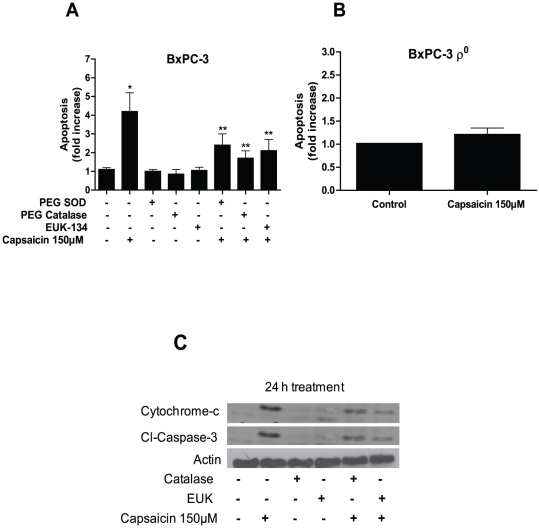
Anti-oxidants prevent capsaicin-induced apoptosis.(A) BxPC-3 cells were pretreated with PEG-SOD (100 U/ml), PEG-catalase (500 U/ml) or EUK-134 (50 µM) for 1 h and then treated with DMSO or 150 µM capsaicin for 24 h, (B) BxPC-3 ρ0 cells were treated with DMSO or 150 µM capsaicin for 24 h, and apoptosis was determined using annexin-V/FITC and propidium iodide and analyzed by flow cytometery. Results are expressed as mean ± SD (n = 3) of three independent experiments. *Statistically different when compared with control (P<0.05) or ** statistically significant when compared with capsaicin treatment (P<0.05), as analyzed by one-way ANOVA followed by Bonferroni's post-hoc test. (C) Cytochrome-c and Cl-caspase-3 were determined by immunoblotting in BxPC-3 cells pretreated with catalase (2000 U/ml) or EUK-134 (50 µM) for 1 h prior to treatment with 150 µM capsaicin for 24 h. Each blot was stripped and reprobed with anti-actin antibody to ensure equal protein loading. These experiments were performed three times independently and similar results were obtained.